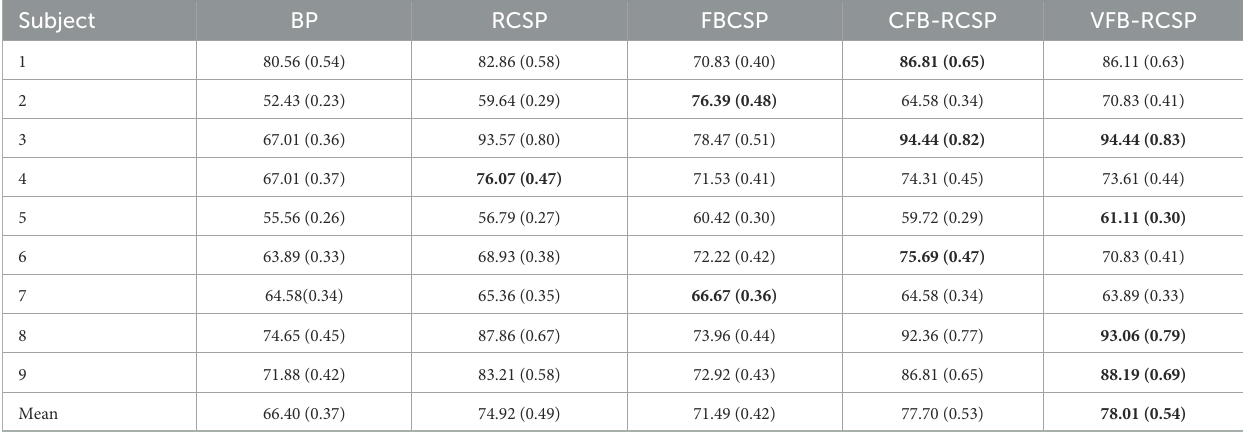
TABLE 1 Classification accuracy of the proposed method and other new methods on Dataset 1.